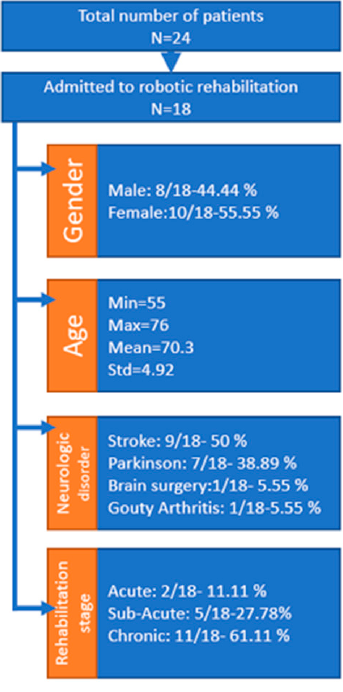
Figure 9. General patient data [52].